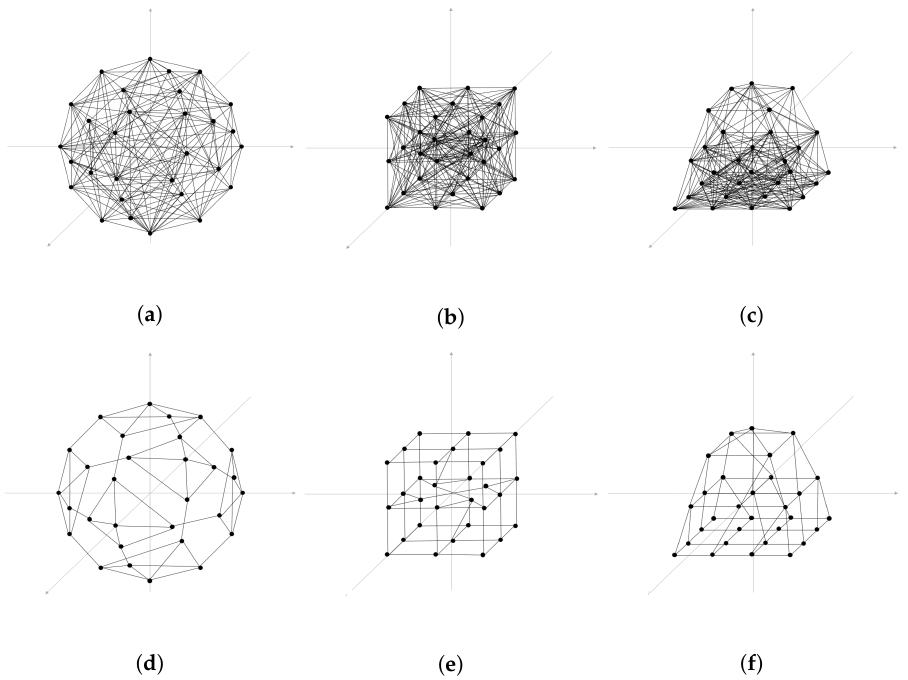
Figure 3. Network connectivity of typical UAV formation after training: ( a ) Full connection of Sphere. ( b ) Full connection of Cube. ( c ) Full connection of Pyramid. ( d ) Training result of Sphere. ( e ) Training result of Cube. ( f ) Training result of Pyramid.